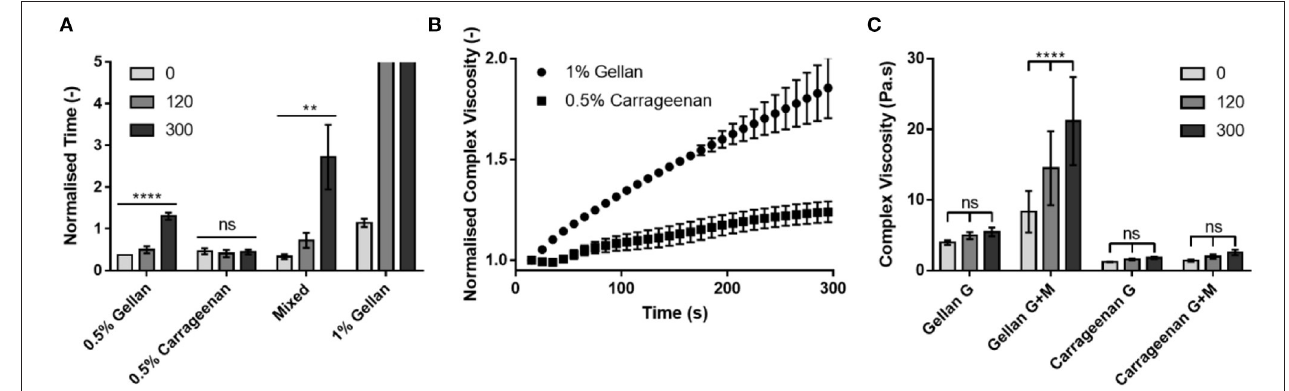
FIGURE 7 | (A) The flow time of each formulation on the mucin-gelatin surface, normalized by that on the gelatin only surface at each application time. (B) The complex viscosity of 1% gellan and 0.5% carrageenan on a mucin gelatin surface over time, normalized for initial complex viscosity, and complex viscosity on a gelatin only surface at each time point. (C) Complex viscosity of each formulation on gelatin (G) and mucin gelatin (G + M), at 0, 120, and 300s. Note that in (A) , drops of 1% gellan did not flow at all on tilting at 120 and 300s. Graphs show mean ± SD ( n = 3). Panel (A) shows the results of ordinary one-way ANOVAs performed on each formulation. Panel (C) shows the results of a two-way ANOVA with a post-hoc Tukey’s multiple comparisons